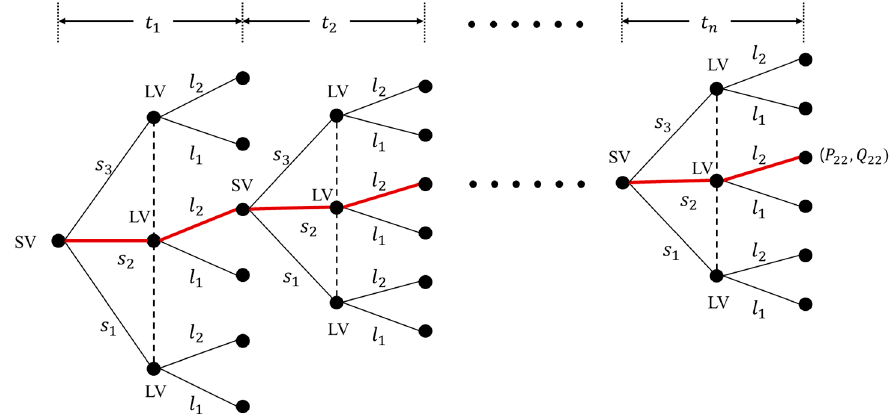
Figure 3. Decision-making game based on the repeated game approach in extensive form.